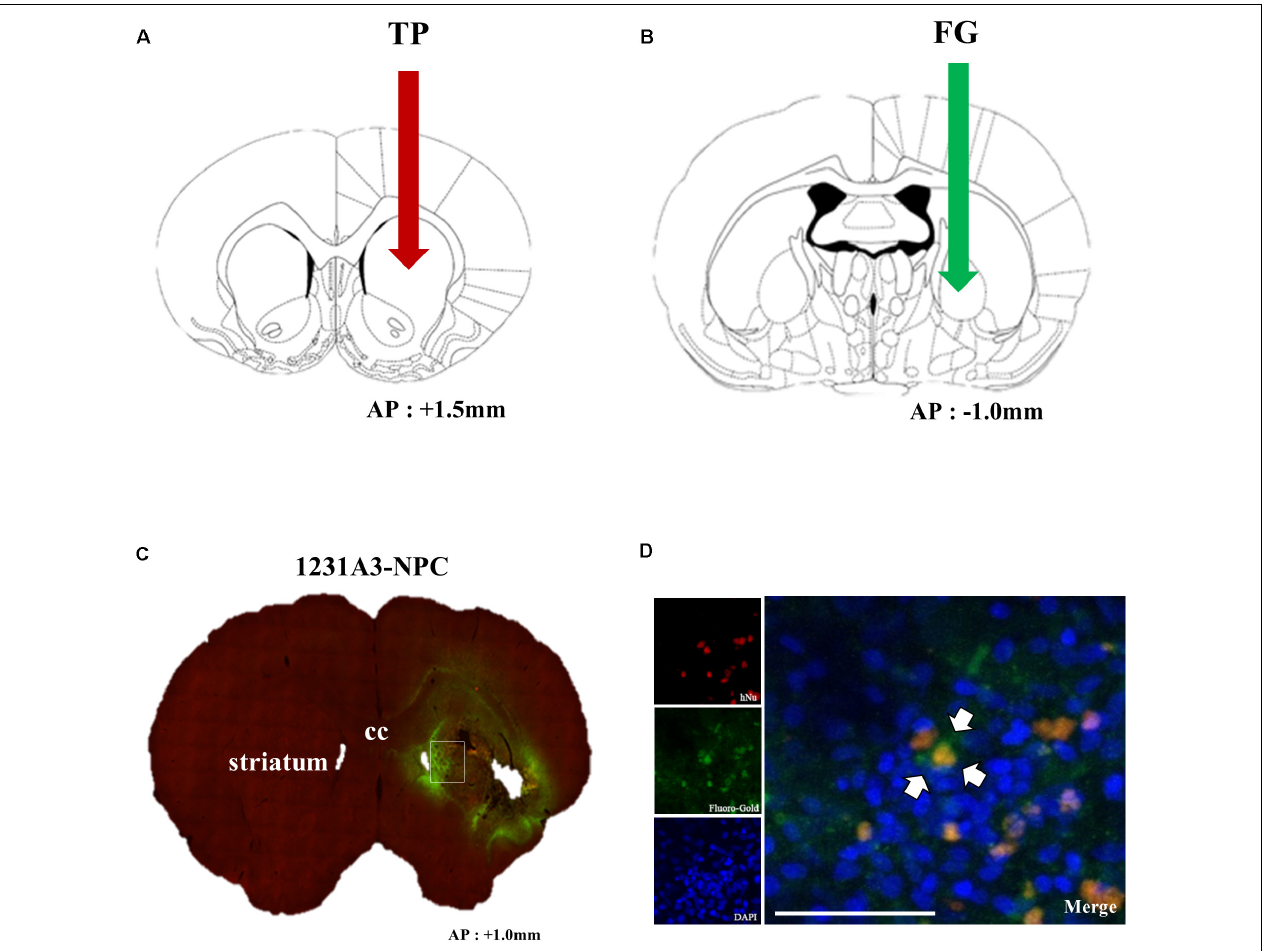
FIGURE 6 | Assessment of the connection of transplanted 1231A3-NPCs to the host tissue using FG labeling. (A) Location for intrastriatal TP of 1231A3-NPCs. (B) Location of the FG injection 12 weeks post-TP. (C) Distribution of FG signals in the whole brain sections. (D) Confocal image of double immunostaining with antibodies against hNu and FG in the striatum. Scale bar = 50 µ m. NPCs, neural precursor cells; FG, Fluoro-Gold; TP, transplantation; hNu, human-specific nuclei. Arrows in Figures (A,B) indicate TP